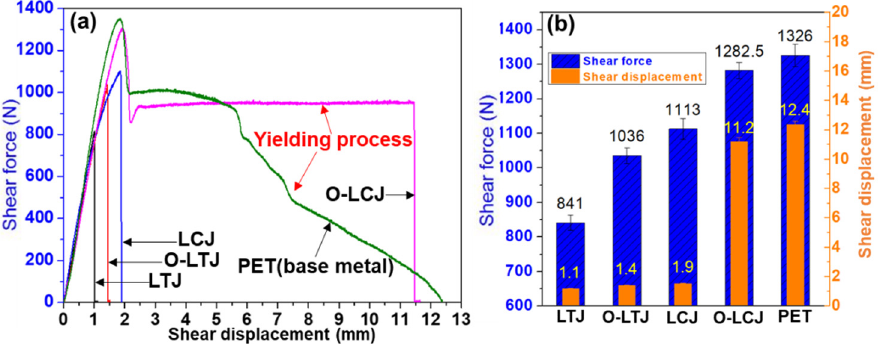
Figure 5. ( a ) Tensile curves (each parameter shows a sample); ( b ) tensile properties of the